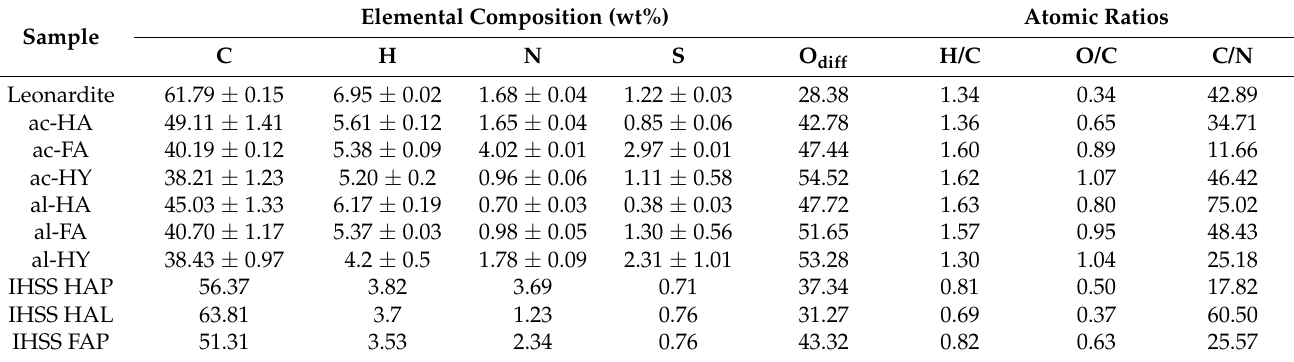
Table 2. The results of the elemental analysis of the samples. Where the C, H, N, O, and S are the mass content, and the different atomic ratios are shown to compare self-extracted samples to IHSS